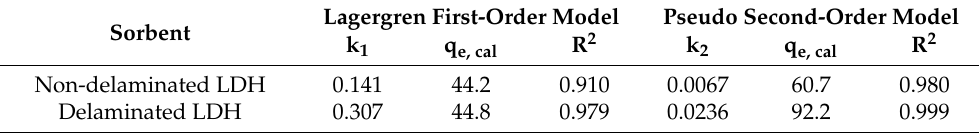
Table 1. Kinetic model parameters for tungstate sorption onto delaminated iron-based LDH.